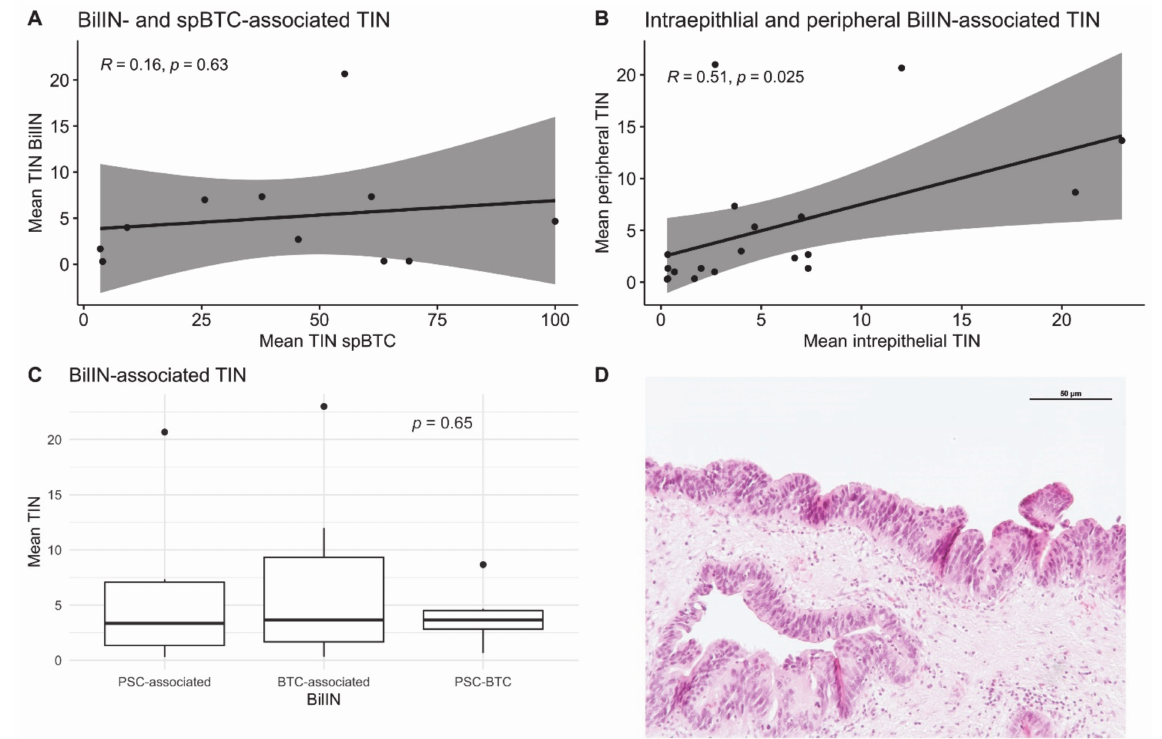
Figure 3. Scatter plot showing the relationship between tumor-infiltrating neutrophils (TINs) in spBTC and BTC-associated biliary intraepithelial neoplasia (BilIN) ( A ) and between intraepithelial and peripheral (stromal) TINs in BilIN lesions ( B ). Best-fitting lines and 95% confidence intervals as well as R coefficients and p values are displayed. Boxplots displaying mean infiltrating neutrophils (TINs) in BilIN from patients with primary sclerosing cholangitis (PSC), in sporadic BTC-associated BilIN and in PSC-related, BTC-associated BilIN (PSC-BTC). The lower and upper hinges correspond to the 25th and 75th percentiles. The upper/lower whiskers represent the largest/smallest observation less/greater than or equal to upper/lower hinge +/ − 1.5 times the interquartile range ( C ). Exemplary section of a high-grade BilIN lesion from a patient with BTC. (hematoxylin/eosin staining) ( D